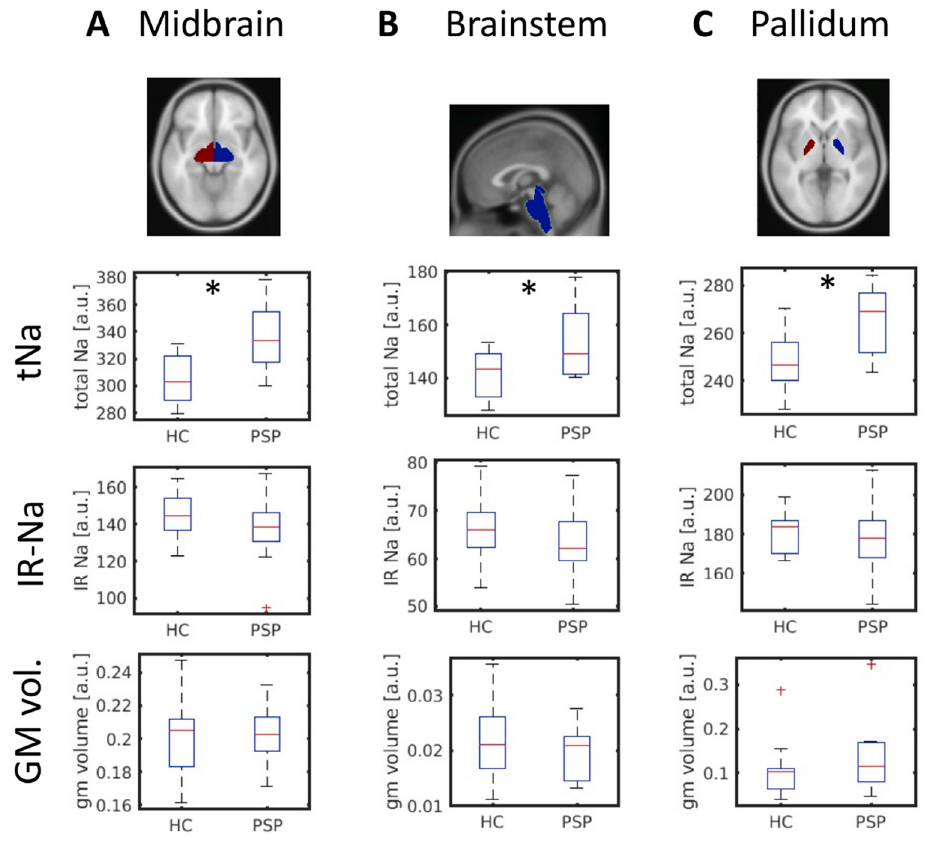
Figure 2. Brain regions showing an increased total sodium (tNa) concentration comparing PSP patients and HC (FDR-corrected). Shown are regions of interest according to the Neuromorphometrics Atlas (( A ): Midbrain, ( B ): Brainstem, and ( C ): Pallidum; top row) and the tNa, IR-Na, and the gray matter volume in the respective regions. a.u.: arbitrary units. GM: gray matter. HC: healthy controls. IR-Na: intracellular-weighted (inversion recovery) 23 Na-MRI. PSP: progressive supranuclear palsy. tNa: total sodium weighted 23 Na-MRI. *: p ≤ 0.05